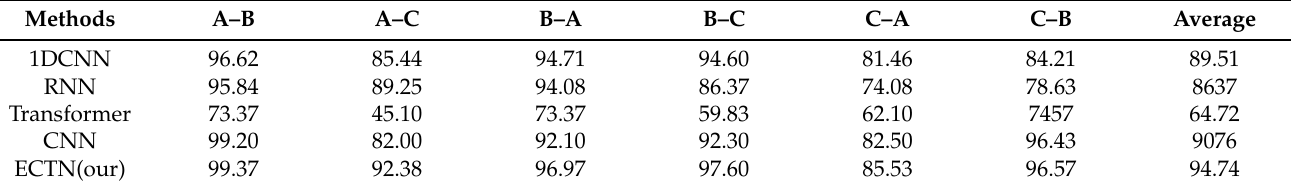
Figure 11. Accuracy histogram with 3000 training samples on CWRU. Table 5. Mean classification accuracy(%) with 3000 training samples on